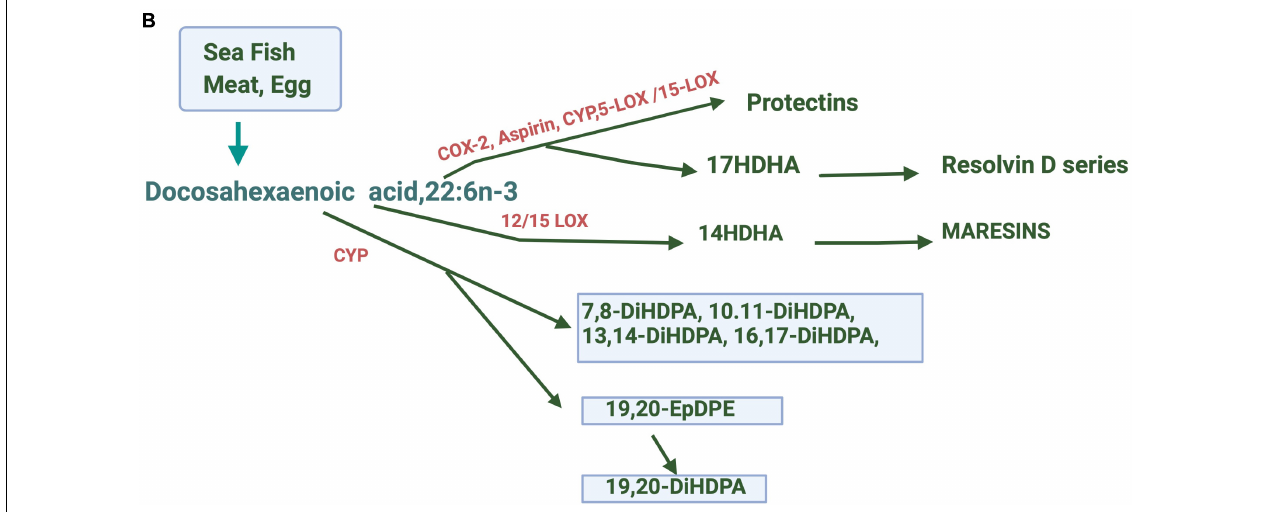
FIGURE 1 | Metabolites of EPA, DHA, and ARA in the body. (A) Arachidonic acid (ARA), and eicosapentaenoic acid (EPA) are metabolized by enzymes such as cytochrome P450 (CYP), lipoxygenase (LOX), or cyclooxygenase (COX). (B) Metabolism of docosahexaenoic acid (DHA) to docosanoids and other derivatives.